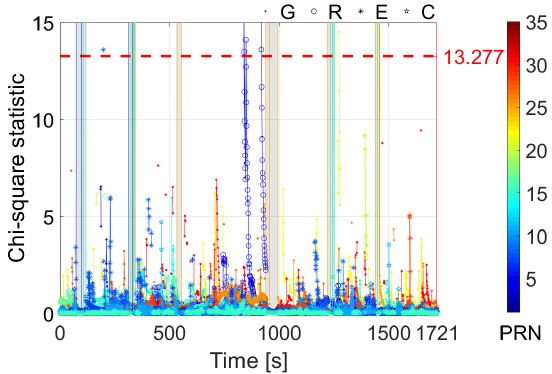
Figure 8. Chi ‐ square statistics during the road experiment. Figure 8. Chi-square statistics during the road